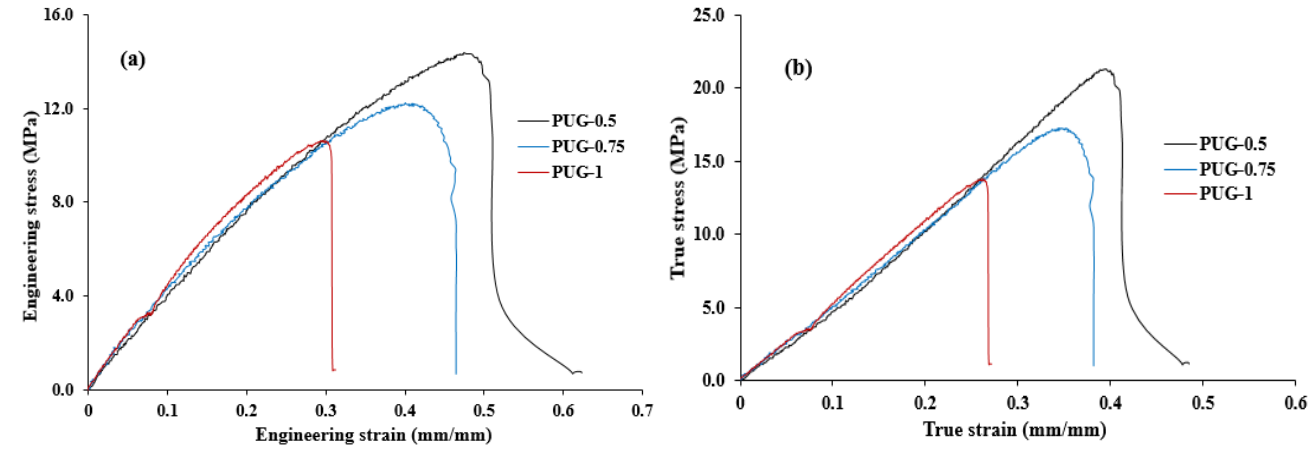
Figure 9. Stress–strain curves of PUGC: ( a ) Engineering and ( b ) True. Figure 9. Stress – strain curves of PUGC: ( a ) Engineering and ( b ) True. Table 6. The engineering properties of the PUGC